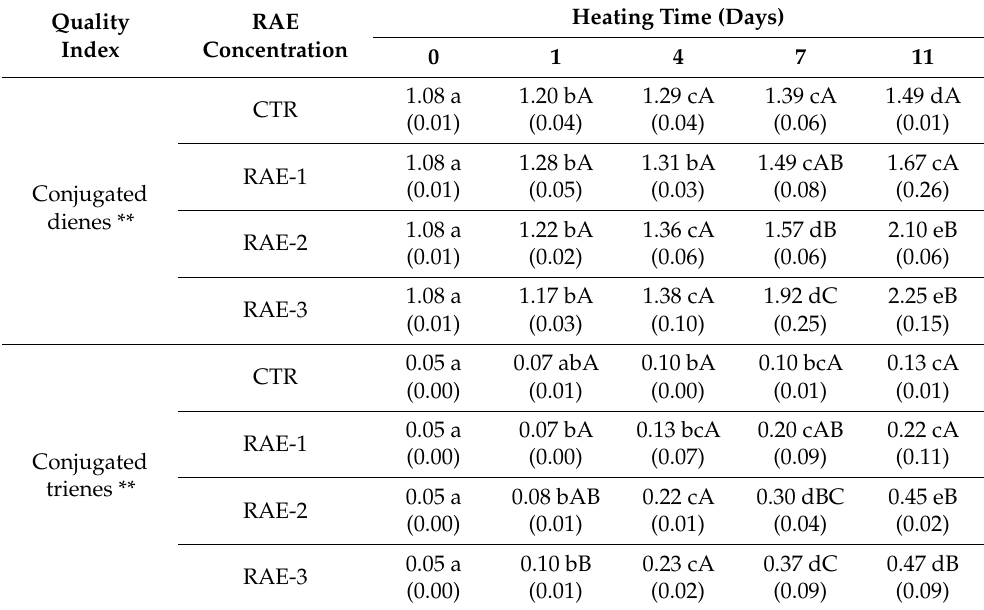
Table 1. The formation of conjugated diene and triene compounds in fish muscle heated in the presence of red alga extract (RAE)